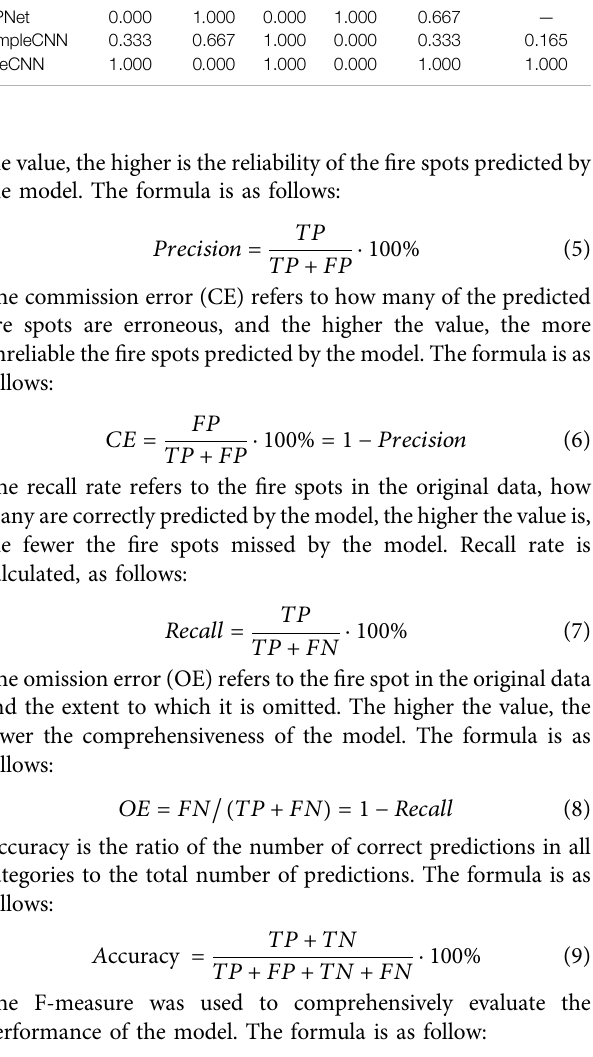
Table 2 . In each of the methods, the training of the deep learning